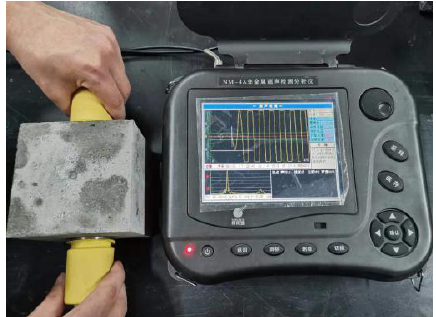
Figure 1. Ultrasonic test diagram.